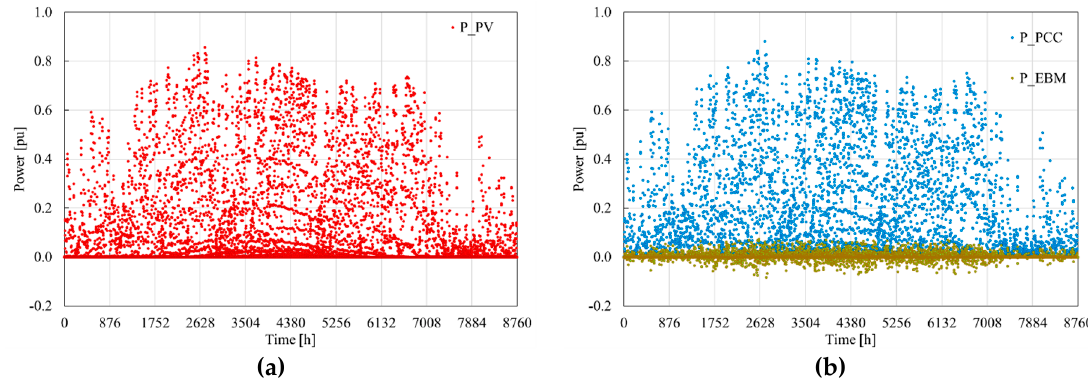
Figure 11. The yearly profiles of ( a ) the power generated by PV system P PV , ( b ) the power at the point of common coupling P PCC and power exchanged with the electricity balancing market P EBM (all related to PV system rated power). Own illustration based on PV GIS data on solar irradiation for LINTE^2 location.